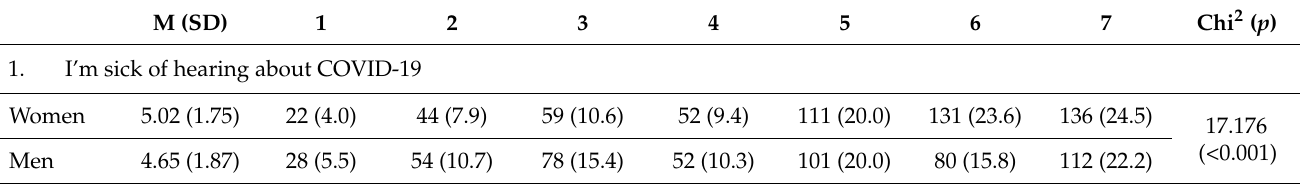
Table 2. Individual items of PFS (M, SD, and frequencies) by gender (n = 1060; n (%)).